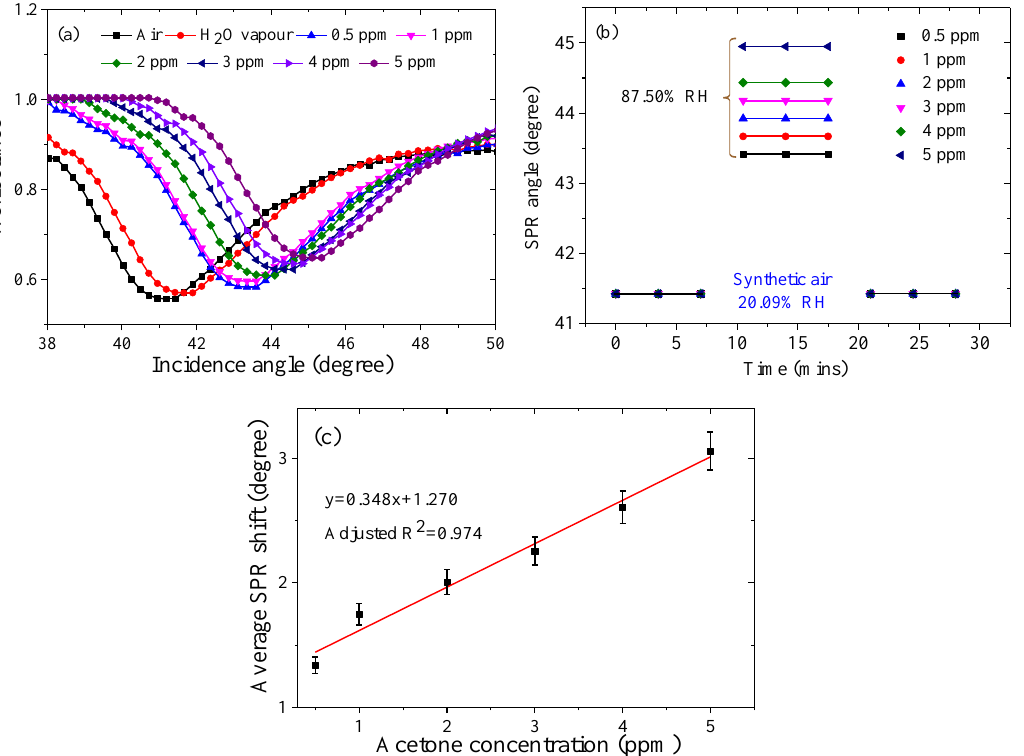
Figure 6. ( a ) Reflectance versus incident angle for the chitosan-PEG-based SPR response in dry air, water vapor, and the various concentrations of the acetone vapor from 0.5 ppm to 5 ppm, ( b ) SPR angle versus time of the single layer chitosan-PEG-based SPR sensor at di ff erent acetone vapor concentrations from 0.5 ppm to 5 ppm as compared to synthetic air levels, and ( c ) SPR angle shift versus acetone concentration from 0.5 ppm to 5